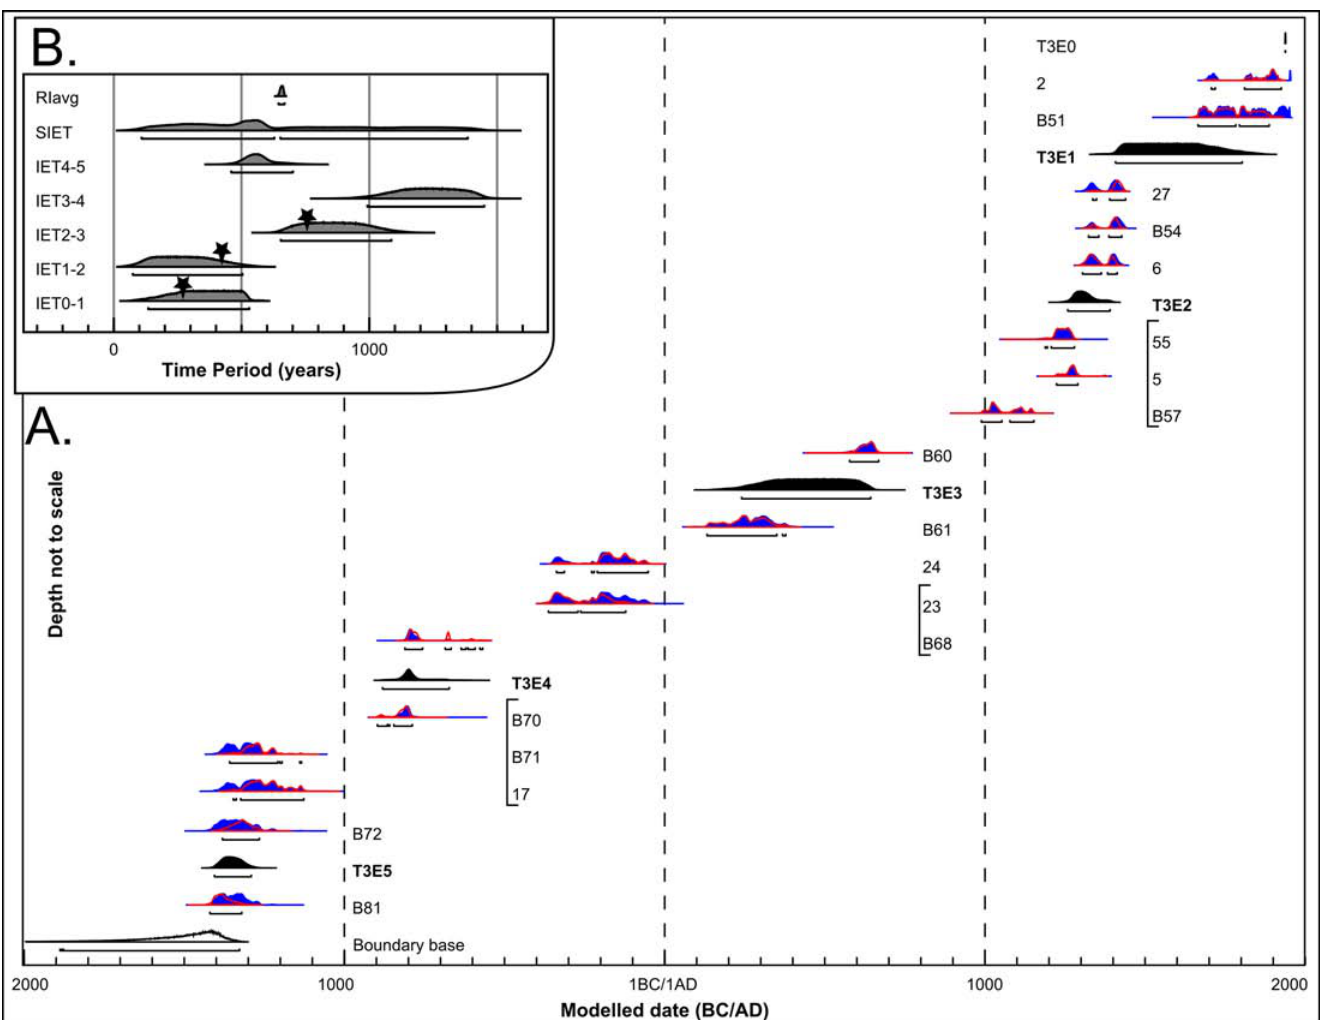
Figure 9. ( a ) Plot of the order-constrained Bayesian model (using OxCal software) [Bronk Ramsey 2007] constructed for trench T3, showing the calibrated sample age probability density functions (PDFs) (blue fill, no boundary), modeled sample age PDFs (no fill, red boundary), and earthquake age PDFs (black filled). Samples that are grouped into phases in the order-constrained Bayesian model (electronic supplement 1) are indicated with brackets. Samples were calibrated using the IntCal04 curve [Reimer et al. 2004]. T3E0 was entered into the model as a fixed date, corresponding to the Erzincan rupture in A.D. 1939. ( b ) Plot of the PDFs of the inter-event times (IETs) calculated using OxCal [Bronk Ramsey 2007]. PDFs labeled IET n-m correspond to individual IETs (i.e. IET0-1 is the IET between event E0 and event E1), SIET is the summed IET, and RIavg is the average recurrence interval. Black stars show the IETs inferred from the correlated historical